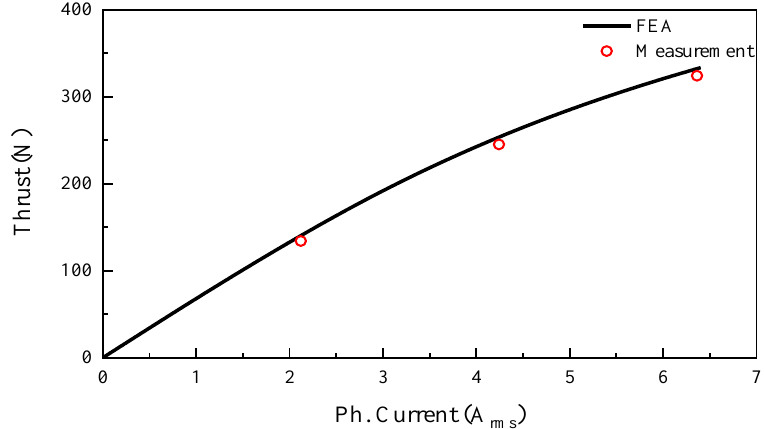
Figure 16. Thrust vs. current characteristics comparison.